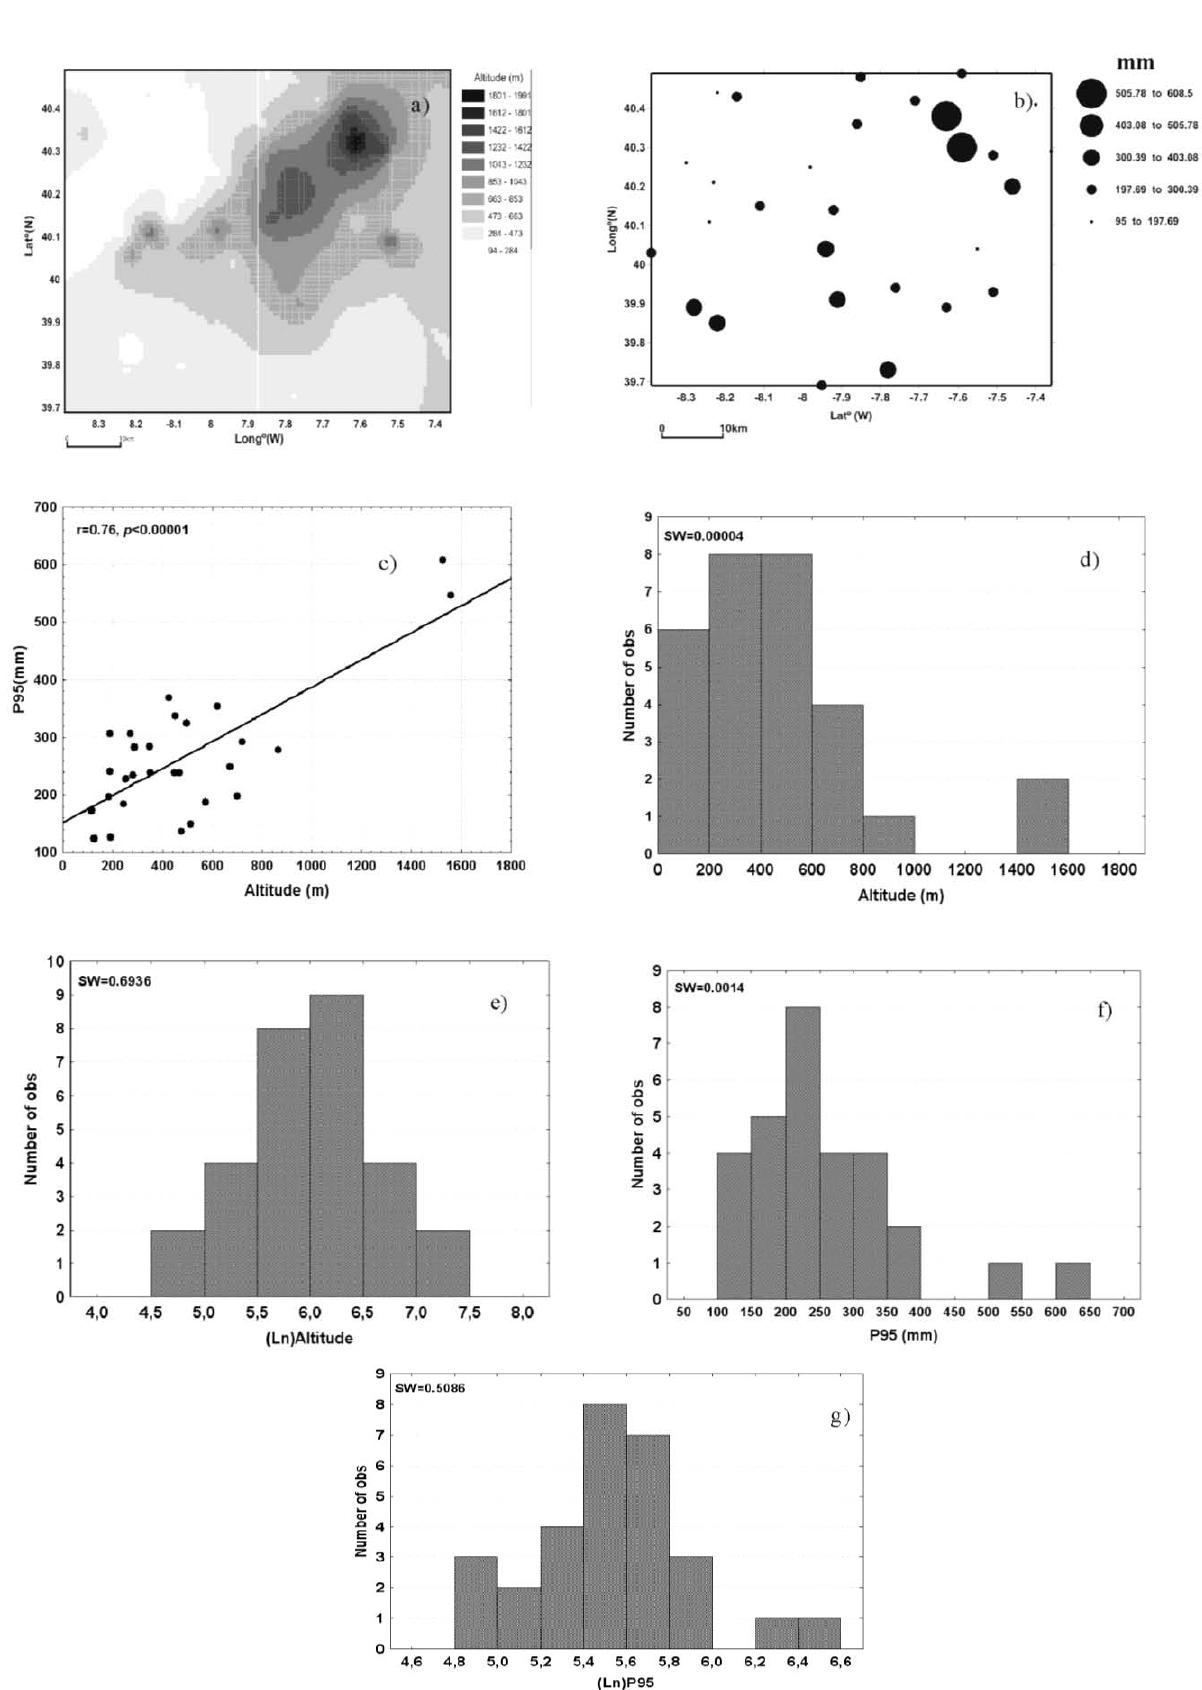
Fig. 2. Digital elevation model of the studied area (a), Symbol map of P95 in the studied area (b), Scaterplot between Altitude and P95 (c), Histogram for altitude (d), Histogram for (Ln)Altitude (e), Histogram for P95 (f) and Histogram for Ln(P95) (g). SW (Shapiro wilk test). Normal distribution considered at a p